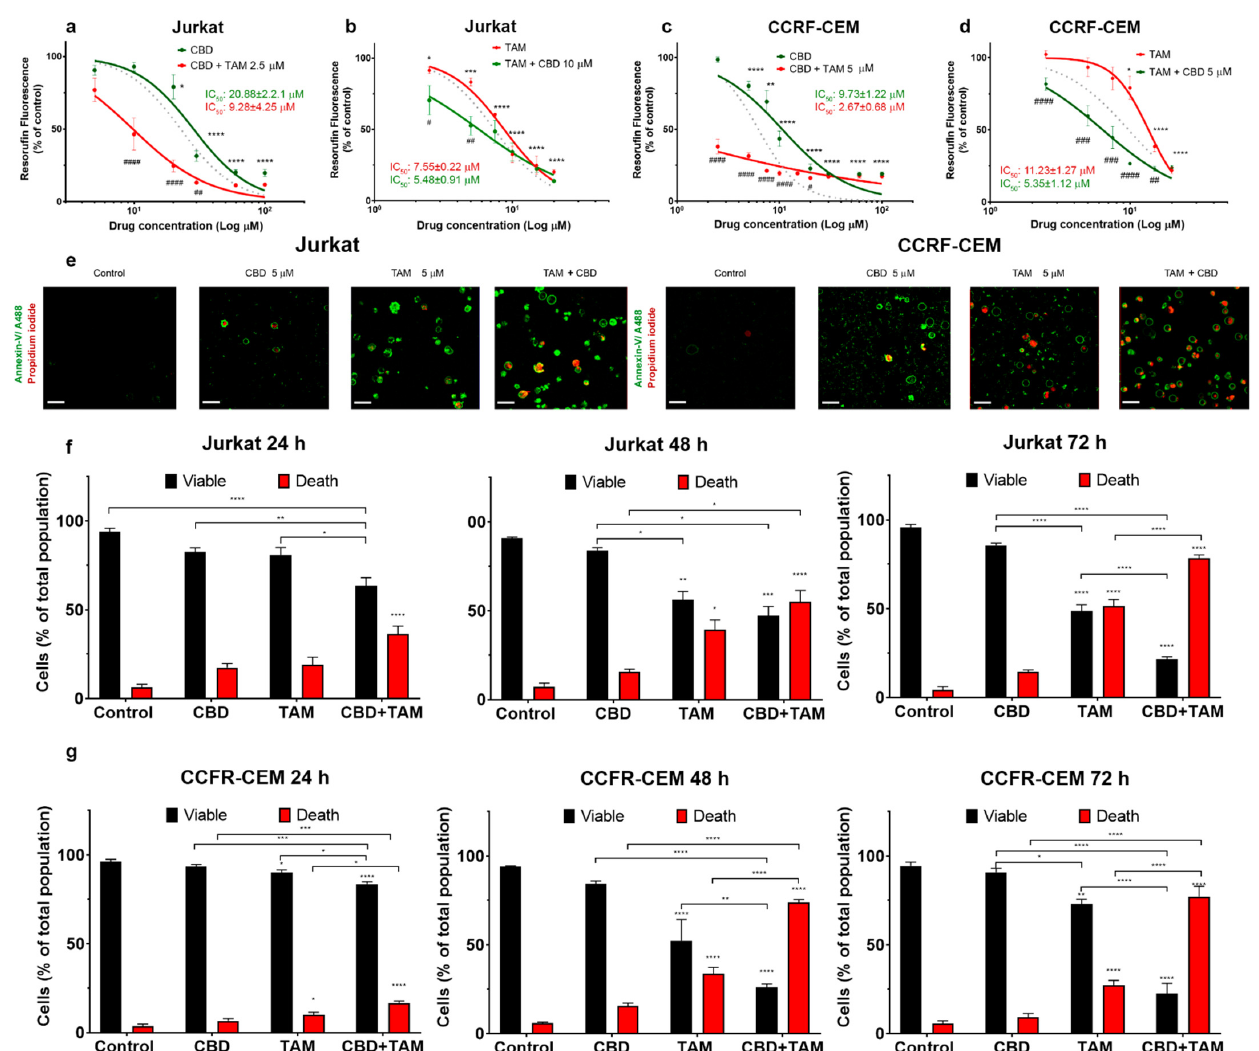
Figure 1. Synergistic cytotoxicity of CBD and TAM against T-ALL cell lines. The cytotoxic effect of CBD (0–100 μ M) and TAM (0–20 μ M) was estimated in Jurkat ( a , b ) and CCFR-CEM cells ( c , d ) at 24 h by measuring resorufin production. Data points are mean ± S.E of at least 3 independent experiments normalized to control group. One-way ANOVA/Dunnett’s multiple comparison test was used for statistical analysis for the dose response curve of single drugs compared to control group (* p < 0.05; ** p < 0.01; *** p < 0.001; **** p < 0.0001). Two-way ANOVA/Bonferroni’s multiple comparison test was used for comparison of the corresponding concentrations between single and co-administration (# p < 0.05; ## p < 0.01; ### p < 0.001; #### p < 0.0001). Dotted lines are predictions under assumption that drugs act independently and additively. ( e – g ) Confocal microscopy analysis of cell death induced by CBD (5 μ M), TAM (5 μ M), or their combination. After treatment, cells were stained with annexin V conjugated to Alexa488 (A488; Ex: 488 nm, Em: 510 nm) and propidium iodide (PI; Ex: 535 nm, Em: 617 nm). ( e ) Representative micrographs of Jurkat ( left ) or CCFR-CEM ( right ) cells treated for 24 h. For statistical analysis, the data were collected at every time point (24, 48 and 72 h) and present as viable (A488 − PI − ), or dead cells, which include apoptotic (A488 + PI − ), necrotic (A488 − PI + ) or double positive (DP, A488 + PI + ) cells in Jurkat. Scale bar represents 20 μ m. ( f ) and CCRF-CEM ( g ) cell populations. Data are mean ± S.E. of at least 3 independent experiments (summarizing at least 180 cells analyzed for each condition). Two-way ANOVA and multiple comparison test Tukey was employed to determine statistical differences between groups (color coded to identify compared groups; * p < 0.05; ** p < 0.01; *** p < 0.001; **** p < 0.0001).